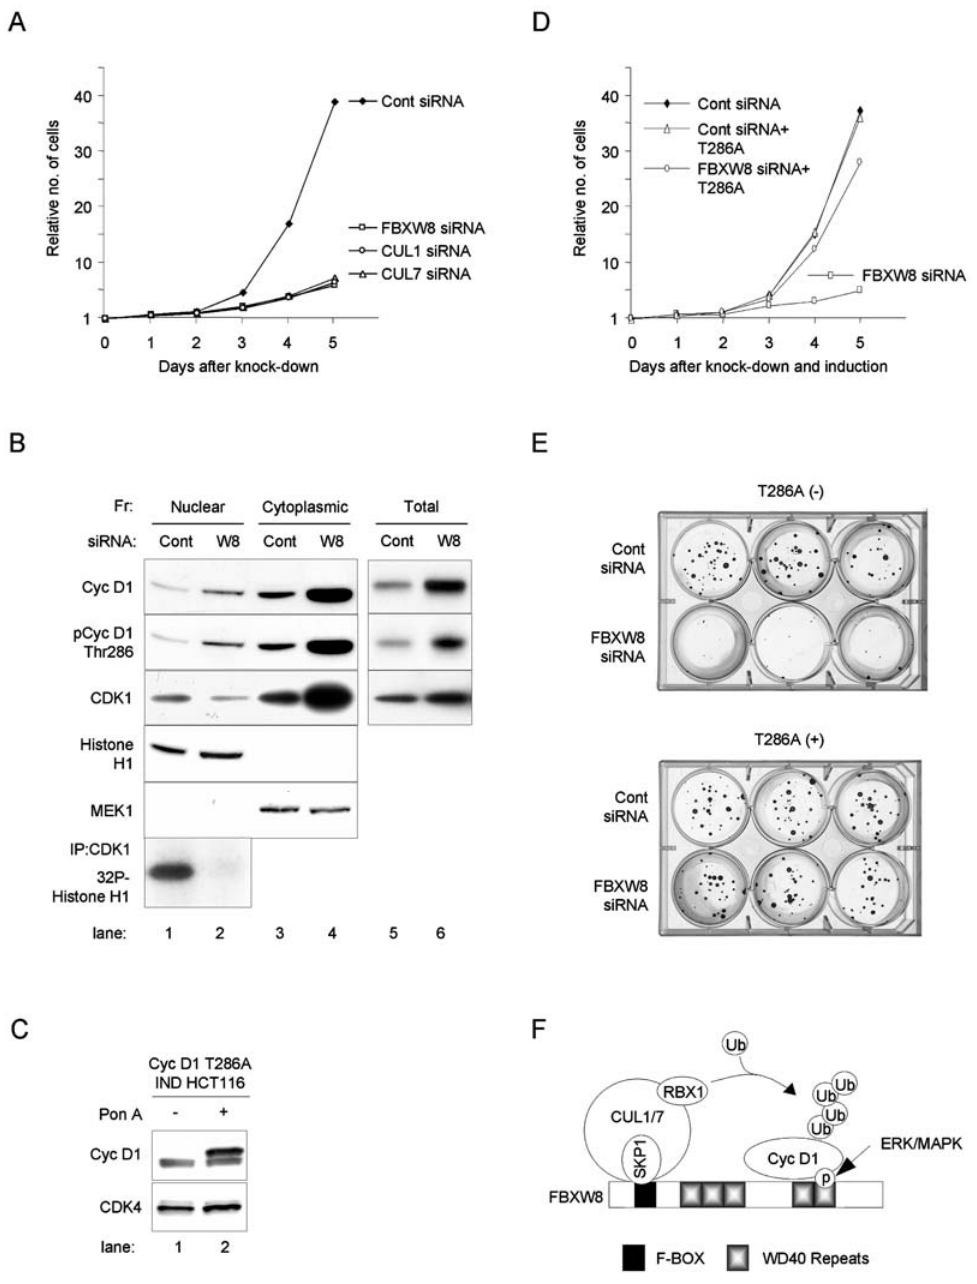
Figure 5. Cyclin D1 degradation in the cytoplasm is essential for cell proliferation. (A) Viable HCT 116 cells after siRNA-mediated knockdown of FBXW8, CUL1, or CUL7 expression. siRNAs were transfected on days 0, 1, 2, and 4. Cells were collected as indicated, stained with trypan blue, and counted with a haemocytometer. (B) Western blot analysis with total and fractionated nuclear proteins. Protein blotting was performed with total cyclin D1 (Cyc D1), pCyc D1 Thr286, CDK1, Histone H1, and MEK1 antibodies. HCT 116 cells were treated with control siRNA (Cont) or FBXW8 siRNA (W8) for 48 hrs. Samples were then fractionated into nuclear or cytoplasmic proteins, or prepared as total cell lysates. The bottom panel shows a CDK1-associated Histone H1 in vitro kinase assay using nuclear protein. (C) Generation of cyclin D1 ecdysone-inducible (IND) system in HCT 116 cells. Ectopic expression of HA-tagged T286A was induced in by 10 m M Ponasterone A (Pon A). (D) Viable cells after T286A cyclin D1 induction. T286A IND HCT 116 cells were cultured in the presence of Pon A (T286A) or its absence, and control (Cont) or FBXW8 siRNA. (E) Colony formation assay. One hundred single T286A IND HCT 116 cells were cultured in the presence of Pon A ( + ) or its absence ( 2 ), and control siRNA (Cont) or FBXW8 siRNA. Cells were cultured for 2 weeks, and stained with 0.5% crystal violet containing 20% ethanol. (F) A model of cyclin D1 ubiquitination mediated by the complex containing FBXW8. FBXW8 recognizes cyclin D1 through a WD40 repeat motif in an ERK/MAPK-mediated Thr286 phosphorylation-dependent manner. SKP1 interacts with FBXW8 together with CUL1 or CUL7 via a domain in the N- terminus of FBXW8, called F-box. CUL1 or CUL7 recruits RBX1, which in turn conscripts E2, a ubiquitin-conjugating enzyme, to add a multiubiquitin chain to cyclin D1. doi:10.1371/journal.pone.0000128.g005 PLoS ONE |